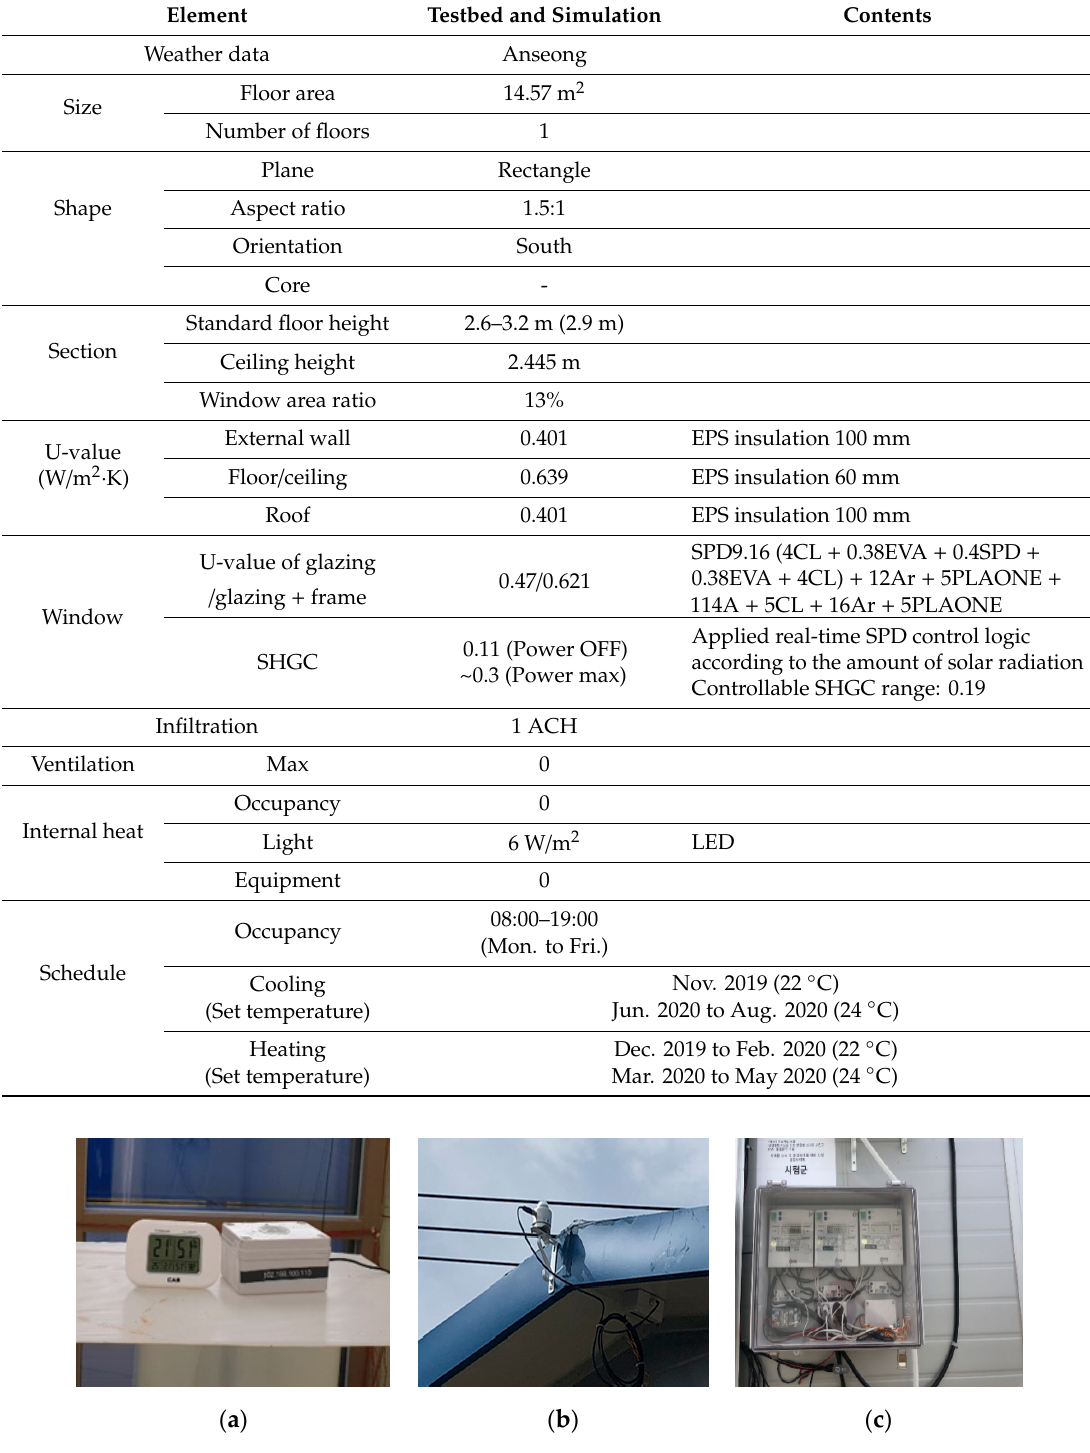
Table 1. Specifications of testbed and simulation input conditions.